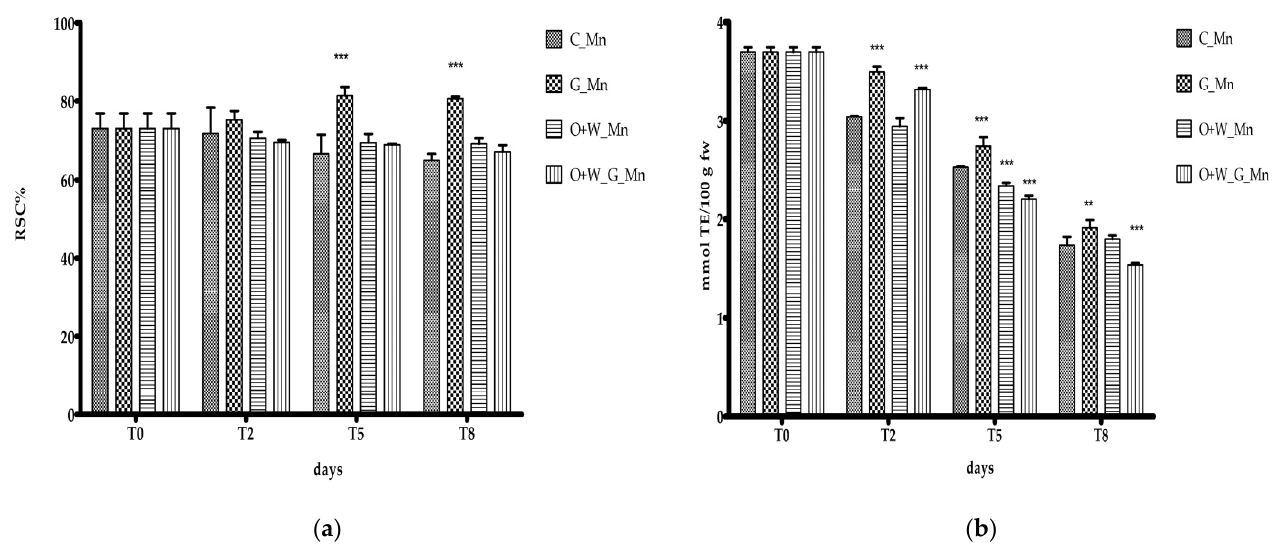
Figure 6. The effects of edible coatings on the antioxidant capacities of mulberry fruits after 8 days of cold storage. ( a ) RSC% as determined by DPPH assay; ( b ) FRAP assay. All values are expressed as the means ± SD (n = 3). The statistical significance (** p < 0.01; *** p < 0.001) was determined compared to the control group at the corresponding time .